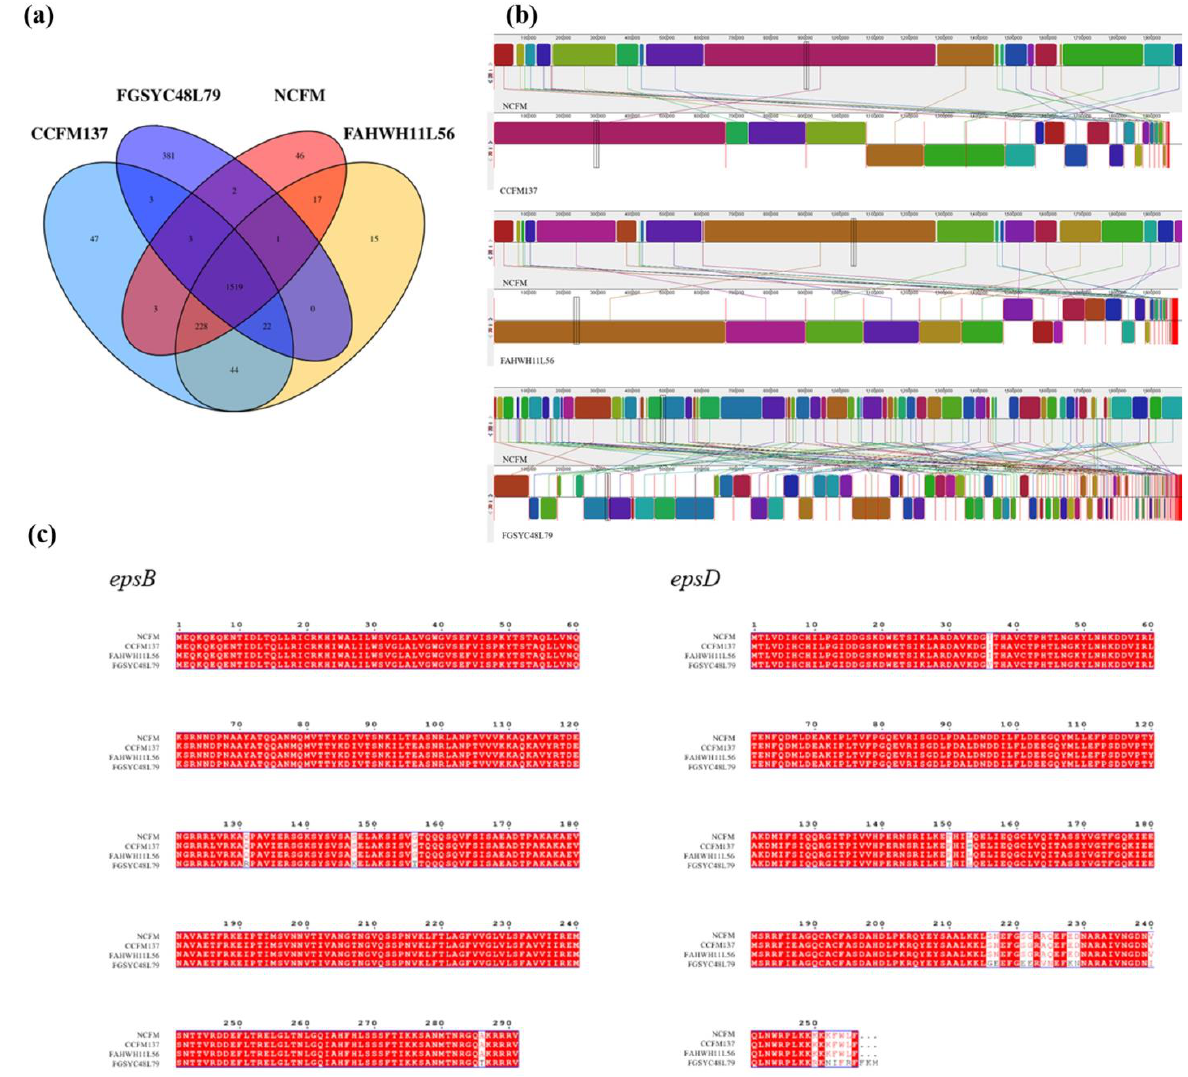
Figure 9. Genomic analysis of L. acidophilus NCFM, CCFM137, FAHWH11L56, and FGSYC48L79. ( a ) Venn diagram of L. acidophilus based on homologous genes, ( b ) the multiple genome alignment of L. acidophilus , and ( c ) amino acid of epsB and epsD multiple sequence alignment of L. acidophilus .